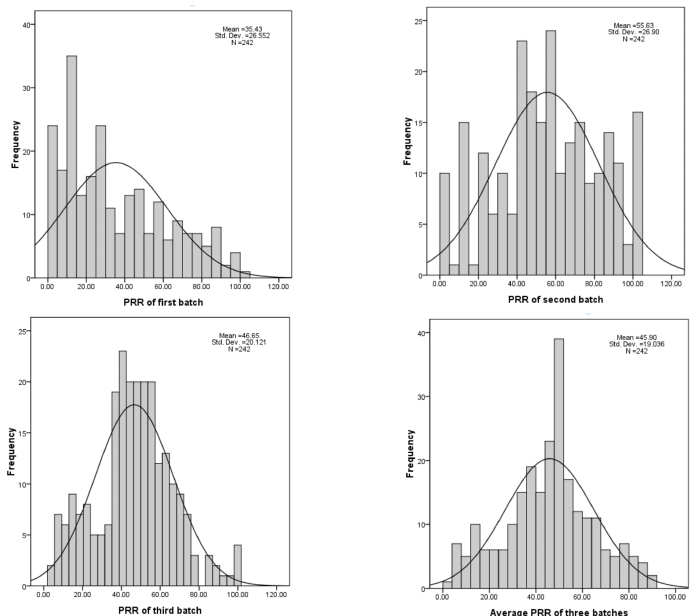
Figure 1. Frequency of G. soja resistance to P. sojae .